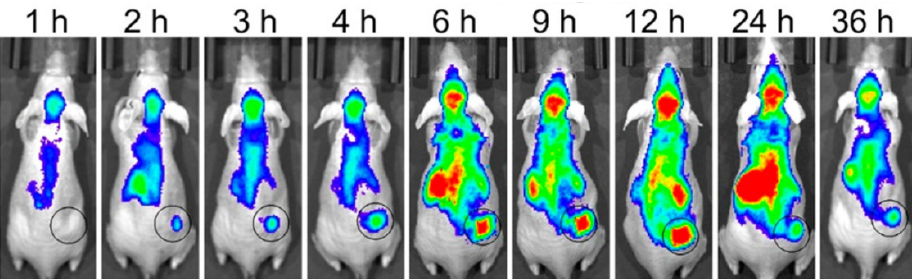
Figure 5. Fluorescence imaging in vivo after intravenous injection with SQU@PCN. Reproduced from ref. [143]. Copyright © 2019 American Chemical Society.